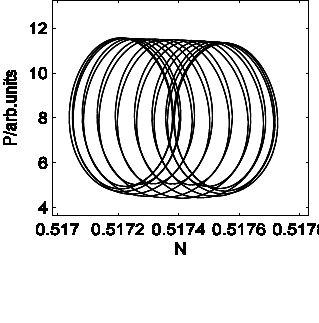
Fig. 13. Another quasi-period.